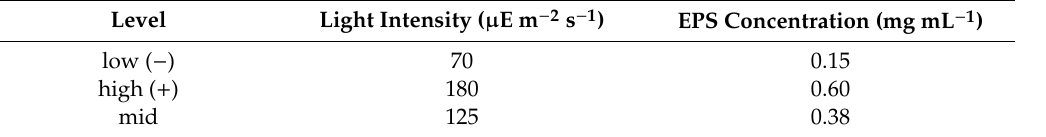
Table 3. The factorial design of experiment.